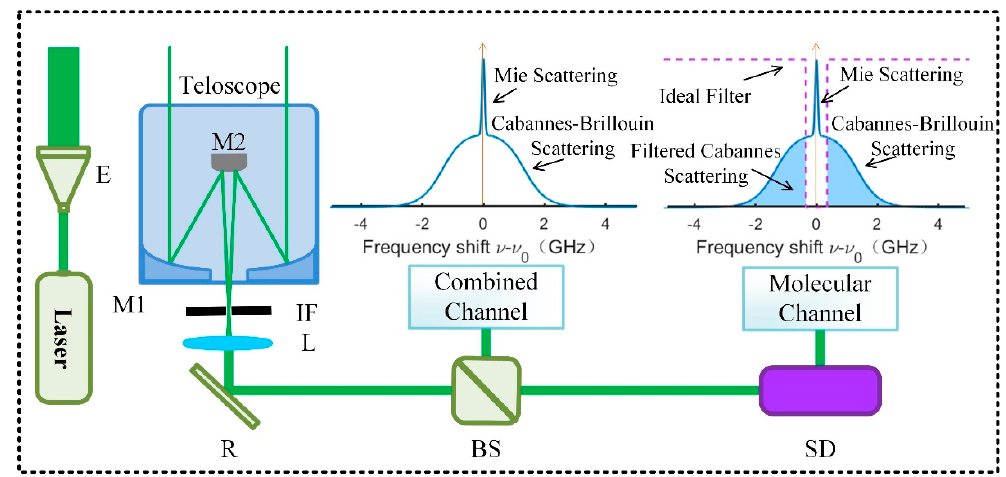
Figure 1. The configuration of a general high-spectral-resolution lidar (HSRL) with the combined channel and molecular channel. ‘E’ = Expander, ‘M’ = mirror, ‘IF’ = Interference filter, ‘L’ = Lens, ‘R’ = Reflector, ‘BS’ = Beam splitter, ‘SD’ = Spectral discriminator.